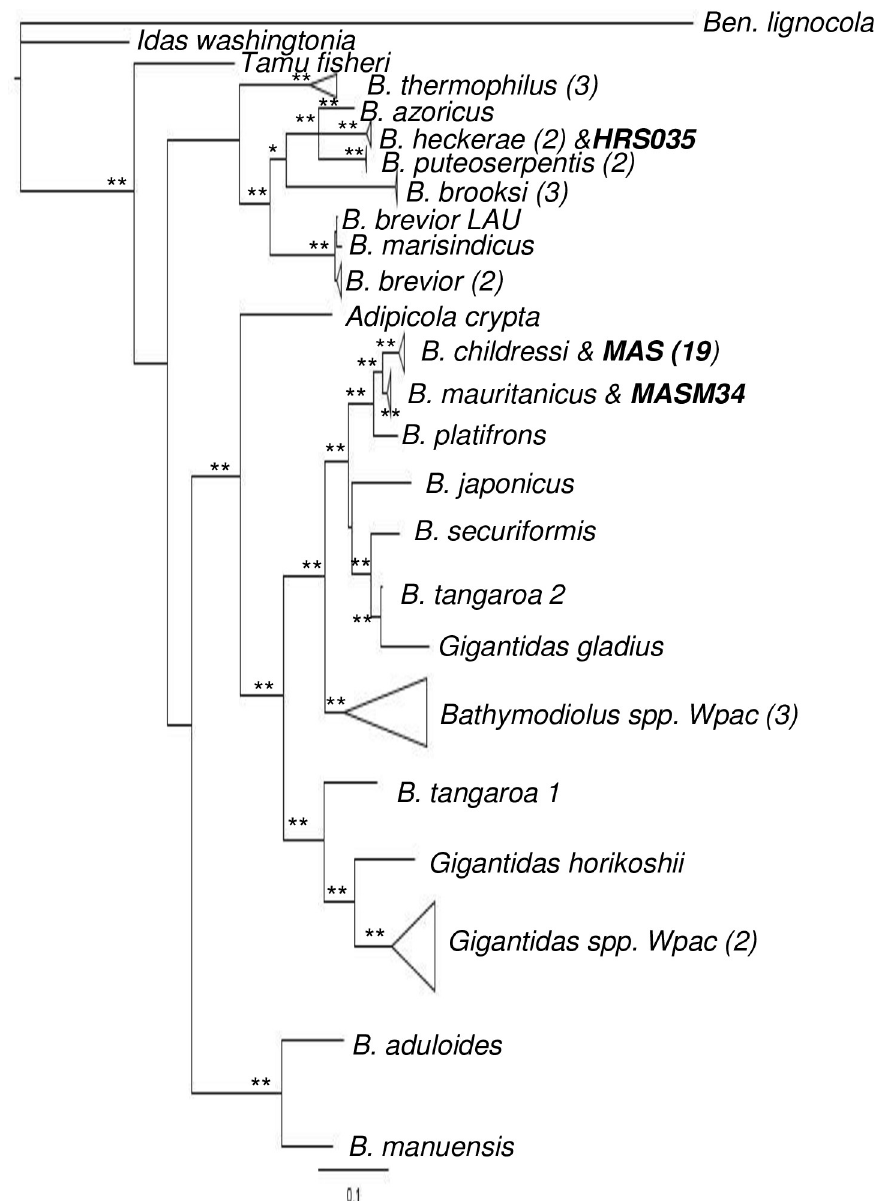
Fig 2. Bayesian phylogeny constructed from mitochondrial COI+ND4 including 21 mussels collected from Mid- Atlantic seep sites (MAS). Posterior probabilities above 0.90 = � ; above 0.95 = �� . S3 Table contains Genbank accession numbers of individuals not collected in this